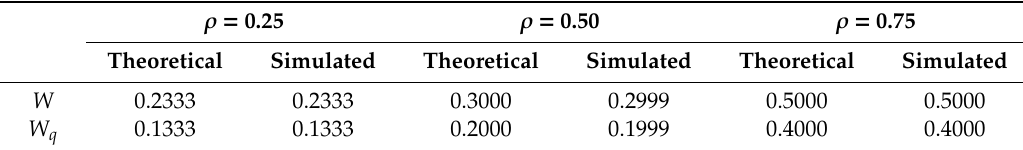
Table 2. Comparisons between theoretical and simulated results for W and W q . ρ = 0.25 ρ = 0.50 ρ = 0.75 Theoretical Simulated Theoretical Simulated Theoretical Simulated W 0.2333 0.2333 0.3000 0.2999 0.5000 0.5000 W q 0.1333 0.1333 0.2000 0.1999 0.4000 0.4000